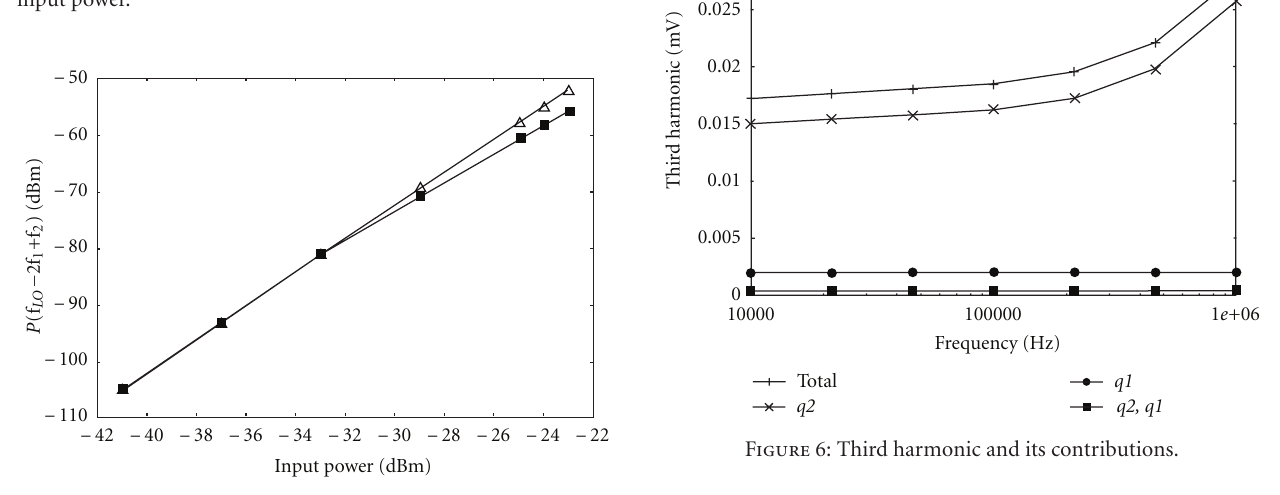
Figure 3: Output power of frequency component ( f LO − f 1 ) versus input power.